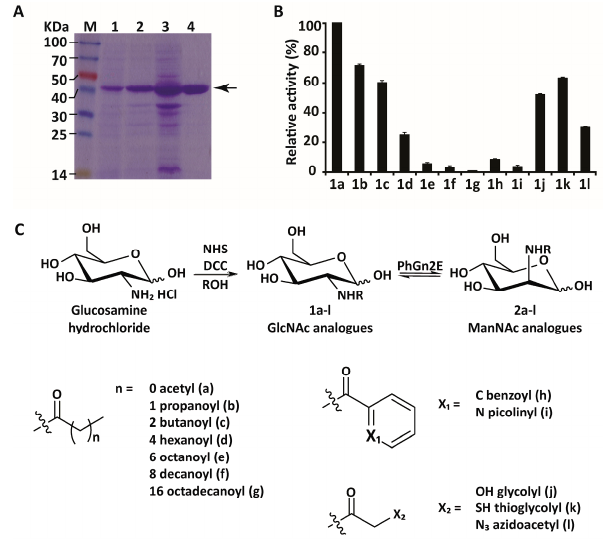
Figure 1. ( A ) : SDS ‐ PAGE analysis of heterologous expressed PhGn2E in E. coli . M: protein marker; 1: cell pellets before induction; 2: cell pellets after induction; 3: supernatant of cell lysate; 4: Ni ‐ NTA